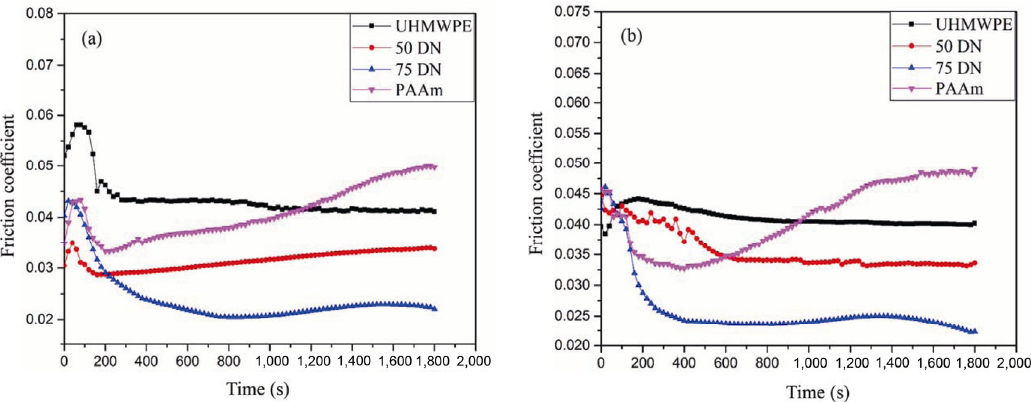
Fig. 7 Changing of friction coefficients with time under different test conditions: (a) 30 N and 60 mm/s, (b) 30 N and 120